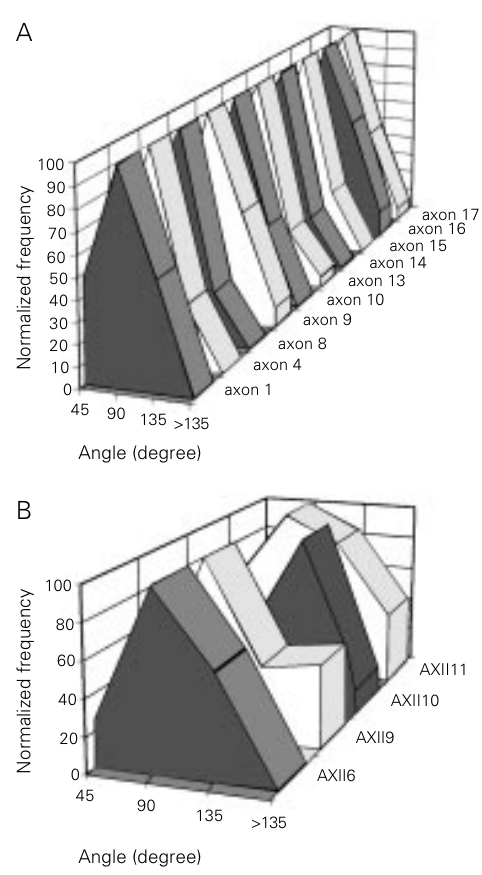
Figure 9 - Branching angles of individual axon terminals of V1 of Cebus apella . A , Type I; B , type II.